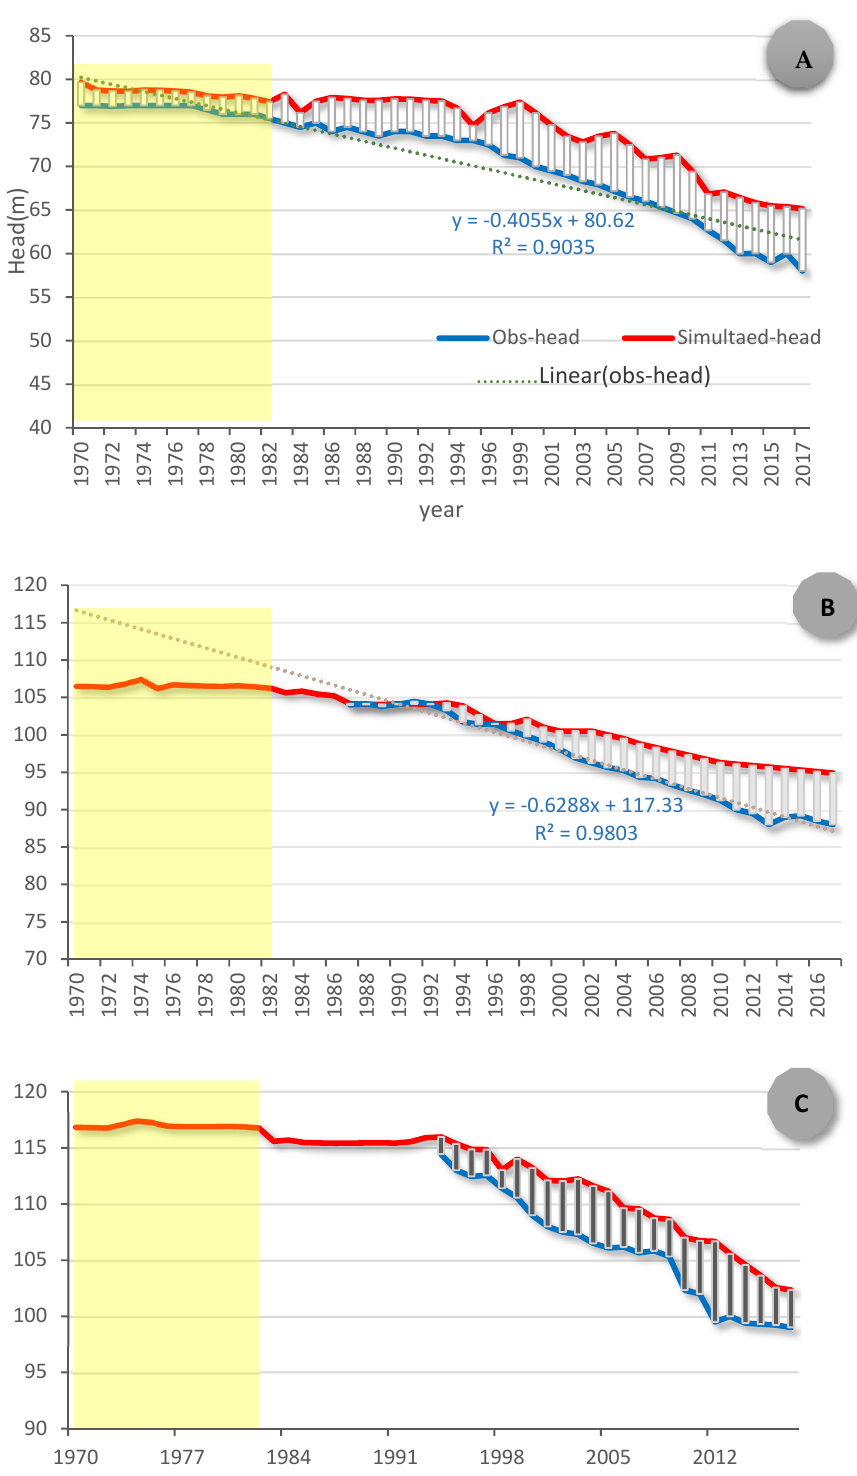
Figure 9. ( A ) Simulated and observed head in piezometer “12737/4”, ( B ) Simulated and observed head in piezometer 77777/4 ( C ) Simulated and observed head in piezometer 19604/4.